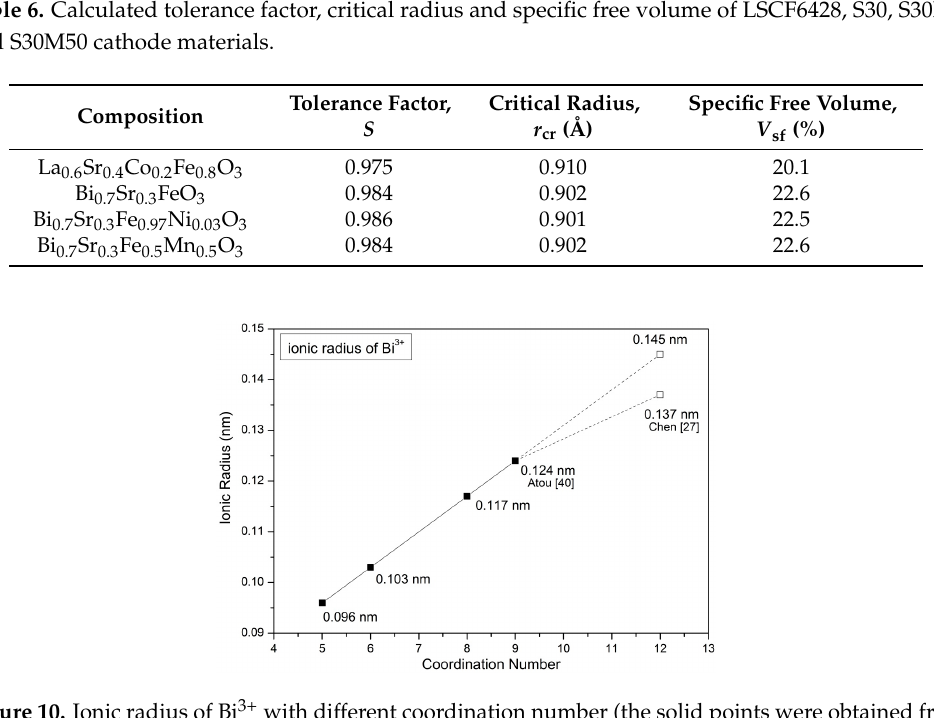
Table 5. Ionic radii of cation used for calculation of the geometry factors [39].